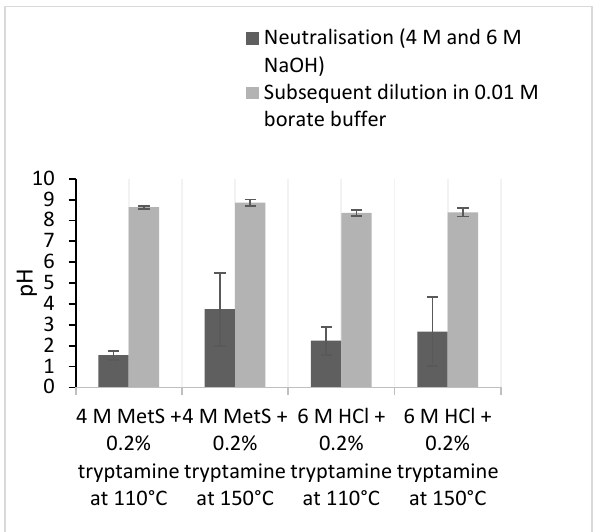
Figure 2. The pH stability achieved by 1:10 dilution with 0.01 M borate buffer following neutralisation with NaOH (4 M or 6 M) ( n = 5). Table 1. Relative levels of total protein in four hydrolysis